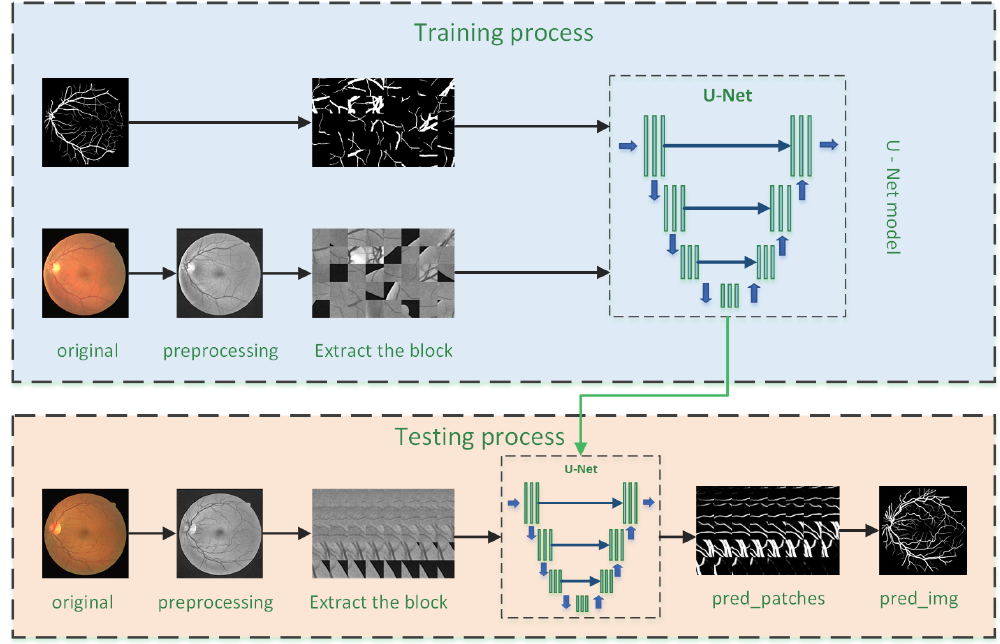
Figure 1. Overview of the architecture framework: the upper part shows the training process of the model; the lower part shows the test process of the model.